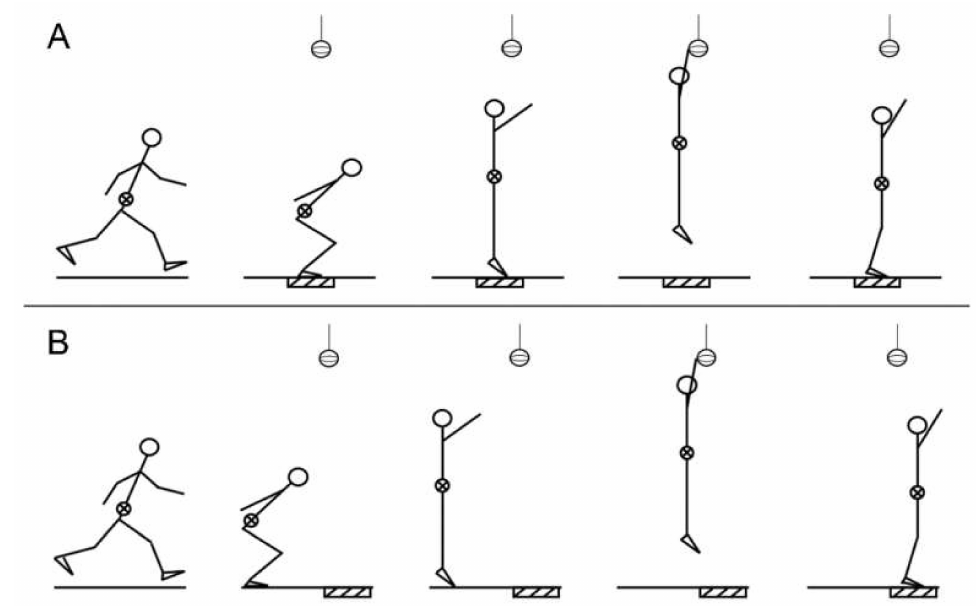
Figure 1. Illustration showing vertical ( A ) and forward ( B ) jump-landing tasks performed in this study. For both VJL and FJL tasks, after the take-off, participants were asked to reach, with their hand, for a target located at 85% of their maximal jump height to avoid potential fatigue effects [21]. The maximum jump height of two maximal effort VJL trials was used to set the target height before the test. The target was a real ball suspended from the ceiling to simulate volleyball jumps as realistically as possible. Landing areas were composed of two force plates of dimensions 60 × 40 cm for the VJL and two 90 × 60 cm force plates for the FJL. For both tasks, participants were instructed to land on their both feet, right foot on the right force plate, left foot on the left force plate. This type of landing was chosen because most volleyball landings are performed with both feet [22]. After landing, participants had to maintain their balance for 5 s without tripping. Participants were asked to perform eight successful trials of each jump-landing task in random order. There was a minimum of 30 s of rest between trials to avoid fatigue. Each participant wore his own training